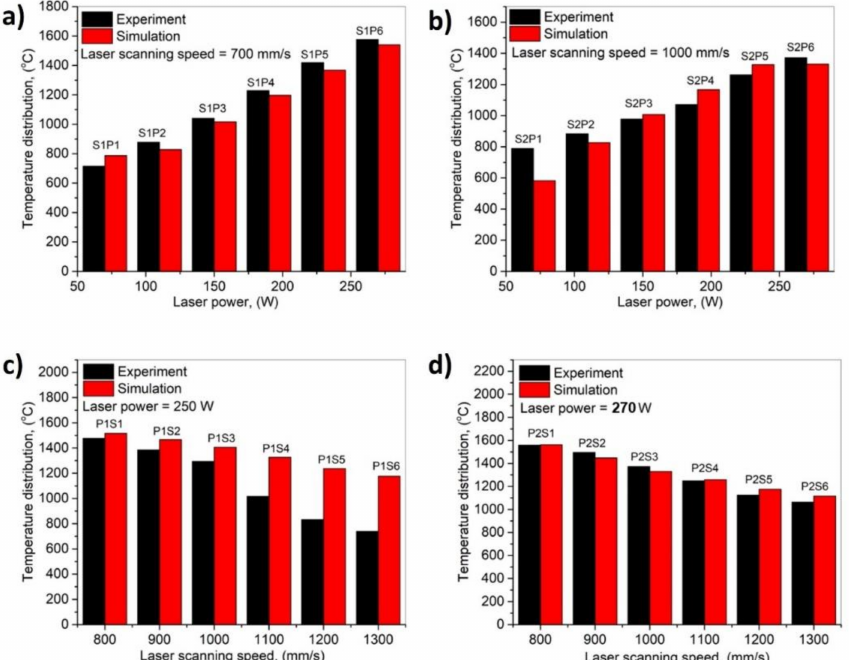
Figure 6. Highest temperature recording comparison with experimentation and simulation: ( a ) S1P1 to S1P6, ( b ) S2P1 to S2P6, ( c ) P1S1 to P1S6, and ( d ) P2S1 to P2S6.